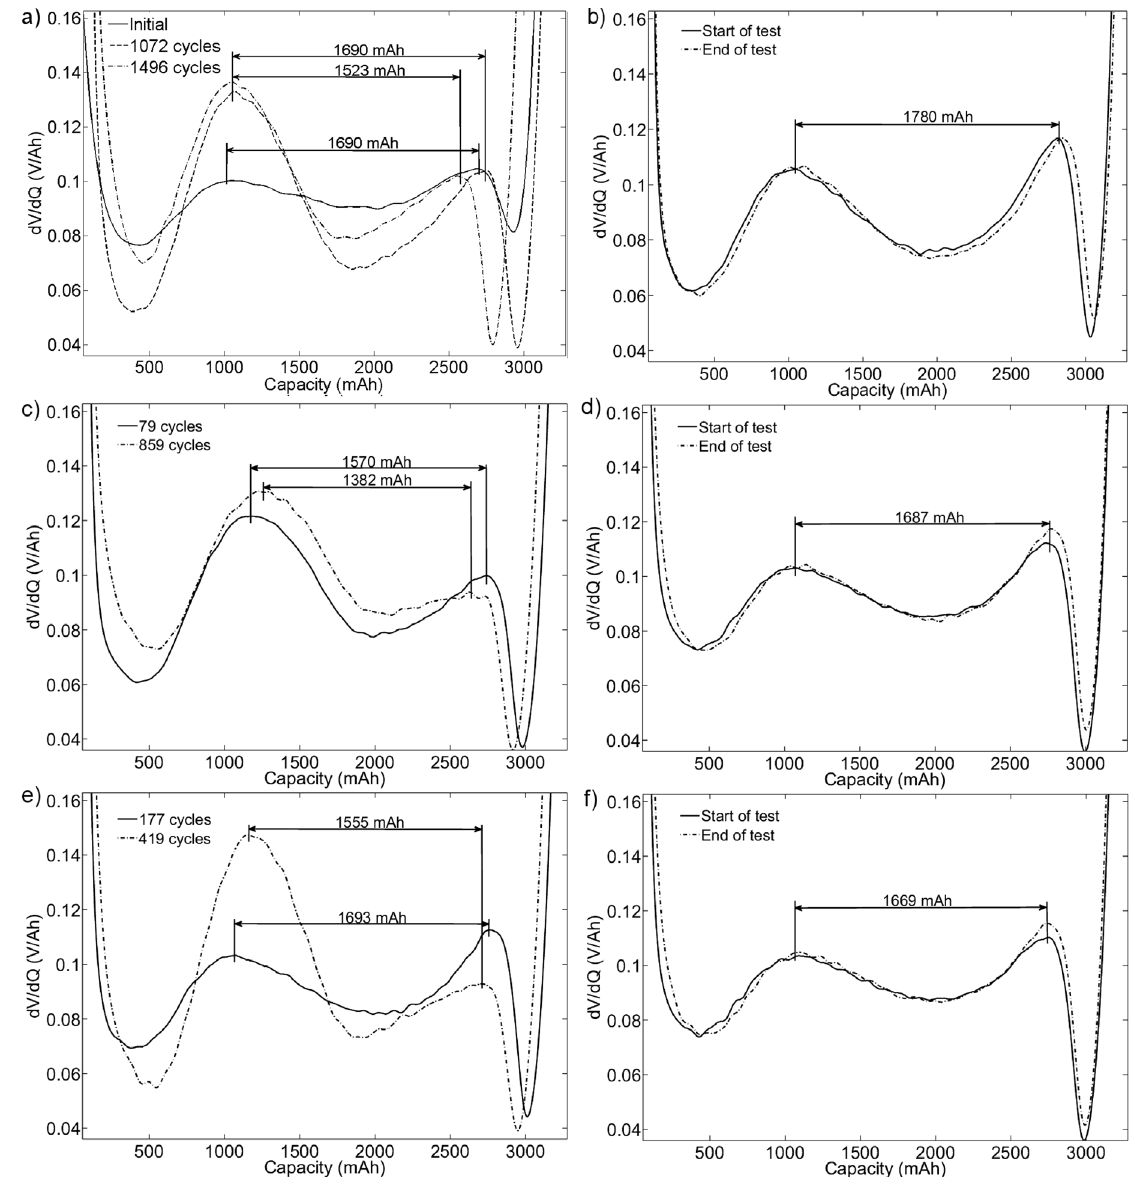
Figure 5. d V /d Q -plots corresponding to the discharge curves in Figure 4: ( a ) cycle-aged cell on Truck 1; ( b ) calendar-aged cell on Truck 1; ( c ) cycle-aged cell on Truck 2; ( d ) calendar-aged cell on Truck 2; ( e ) cycle-aged cell on Truck 3 and ( f ) calendar-aged cell on Truck